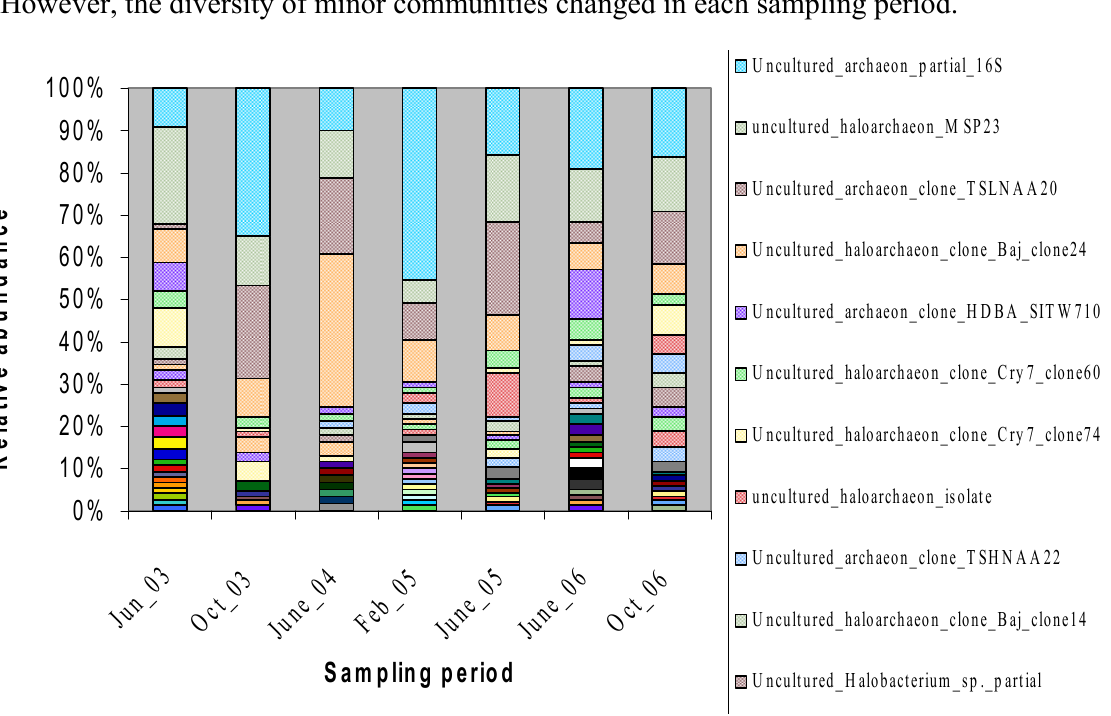
Figure 3. Relative abundance of archaeal community obtained from 16S rRNA gene sequencing in each sampling period. Legends with major relative abundances (>5%) are shown in the